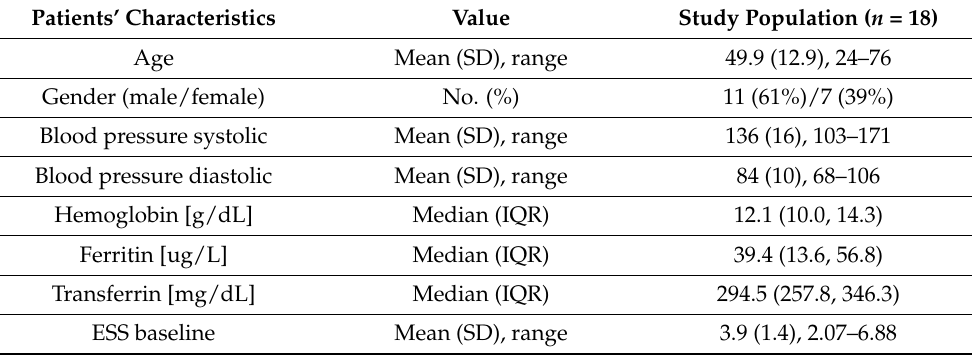
Table 1. Patients’ characteristics of the ITT population. Patients’